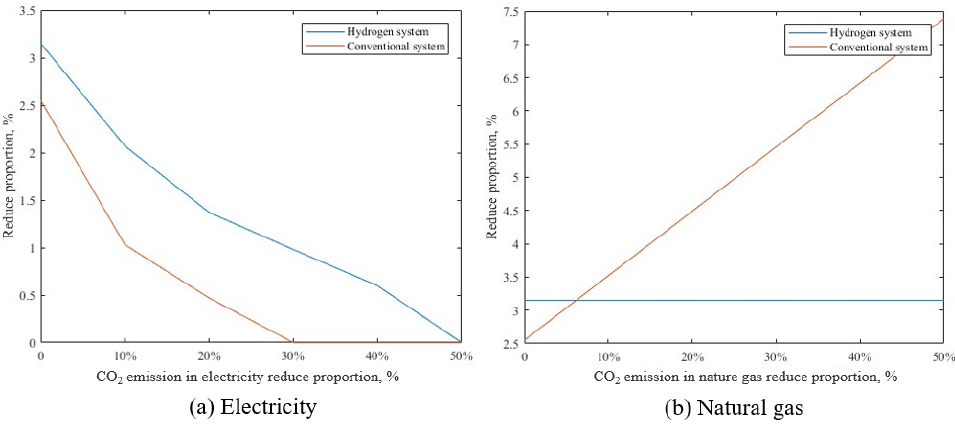
Figure 9. Benefits of different CO 2 emission in electricity ( a ) and natural gas ( b ).